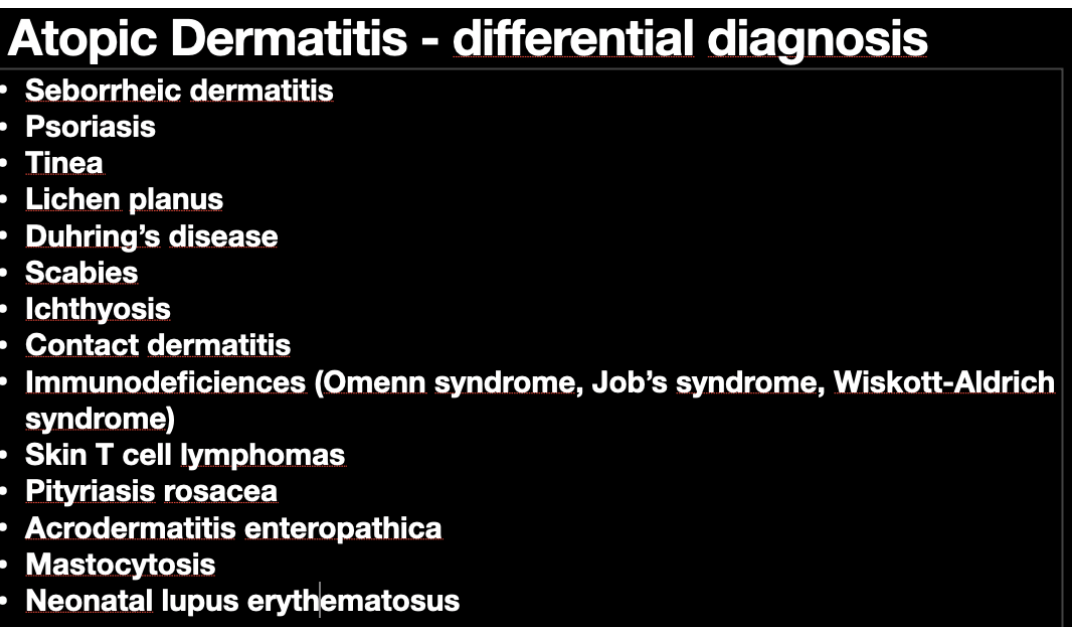
Figure 1. Differential diagnosis of atopic dermatitis (AD). Main potential diseases that can confuse AD diagnosis are included in the table. Many different options do make this an easy way to reach final diagnosis.